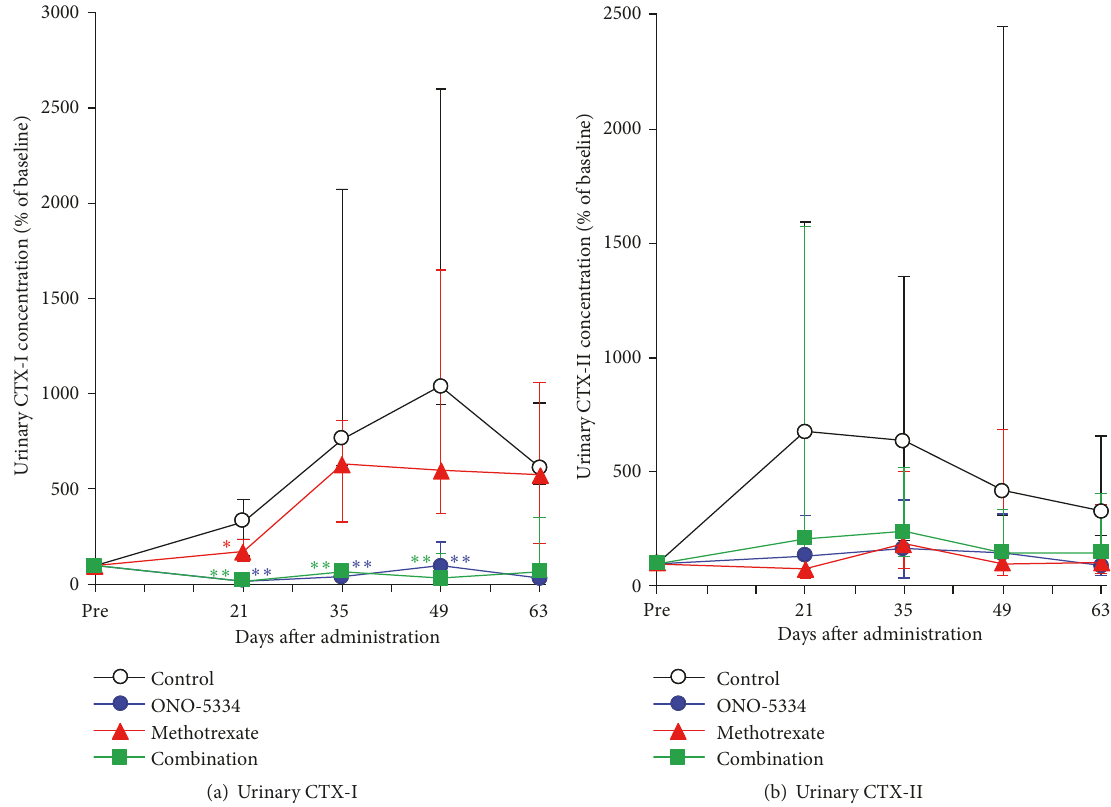
Figure5:PercentchangesinurinaryCTX-I(a)andCTX-II(b)incollagen-inducedarthritismonkeys.Dataareexpressedasmedian(quantile 3-1); control (n=8), ONO-5334 (n=9), methotrexate (n=8), and combination (n=9). ∗ p < 0.05 and ∗∗ p < 0.01 versus control group (Tukey